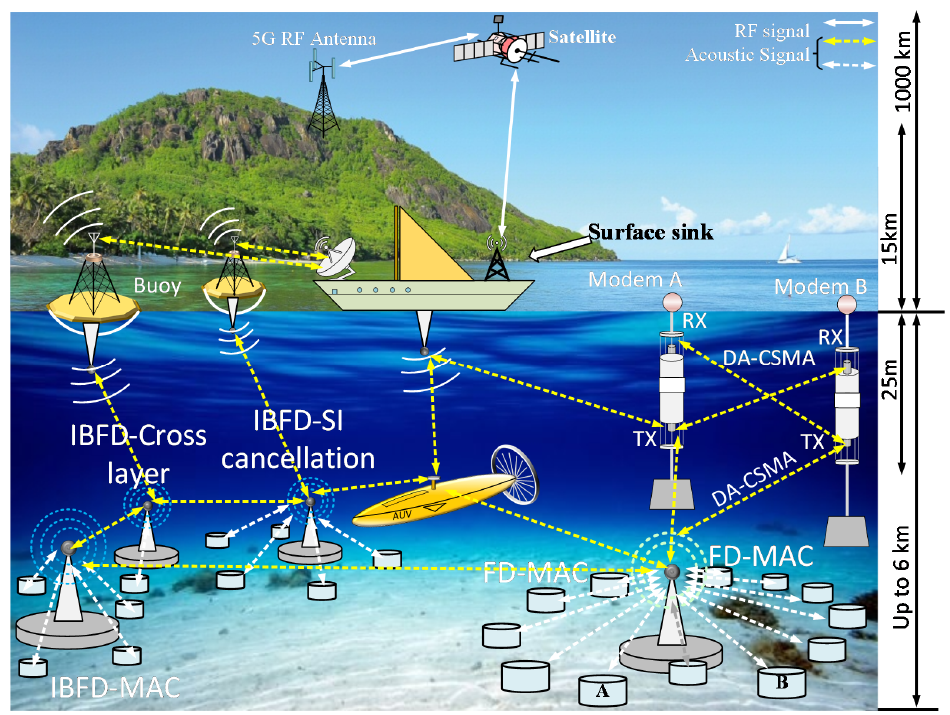
Figure 7. Various FD-PHY and MAC-based UWASNs in a cross-layered perspective.